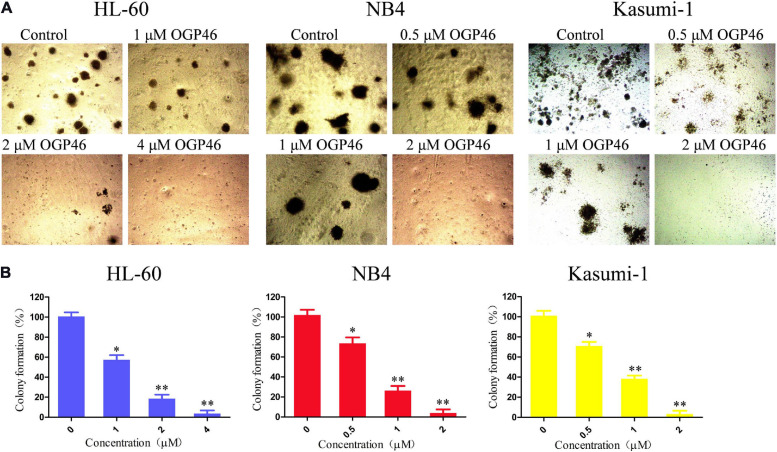
OGP46 reduced the colony-forming efficiency of HL-60, NB4, and Kasumi-1 cells. (A) HL-60, NB4, and Kasumi-1 cells were incubated with OGP46 (0.5–4 μM) for 15 days and then examined with light microscopy. (B) A bar graph showing the statistical analysis of colony-formation number (*p < 0.05 and **p < 0.01).